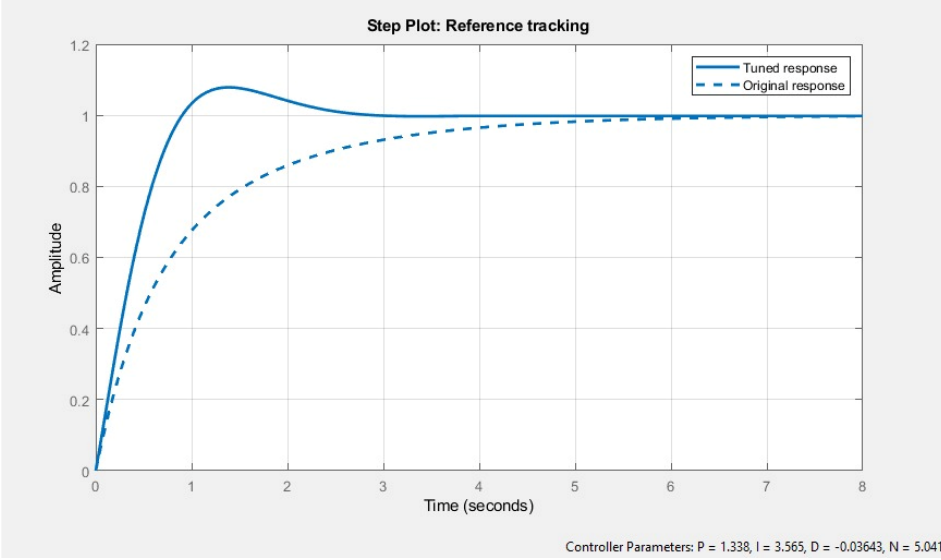
Figure 19. Time response of electrolysis system before tuning and after tuning.